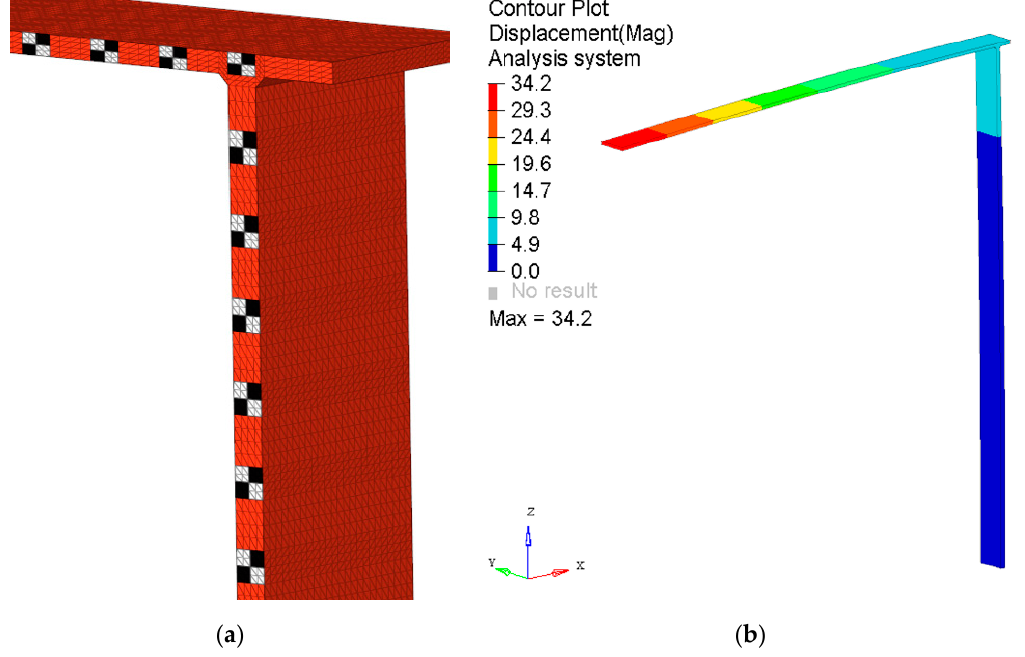
Figure 4. FEM model: close-up view of a finite element mesh in the area of connection of a vertical and horizontal beam ( a ) and the results of deflection of the tested structure ( b ).